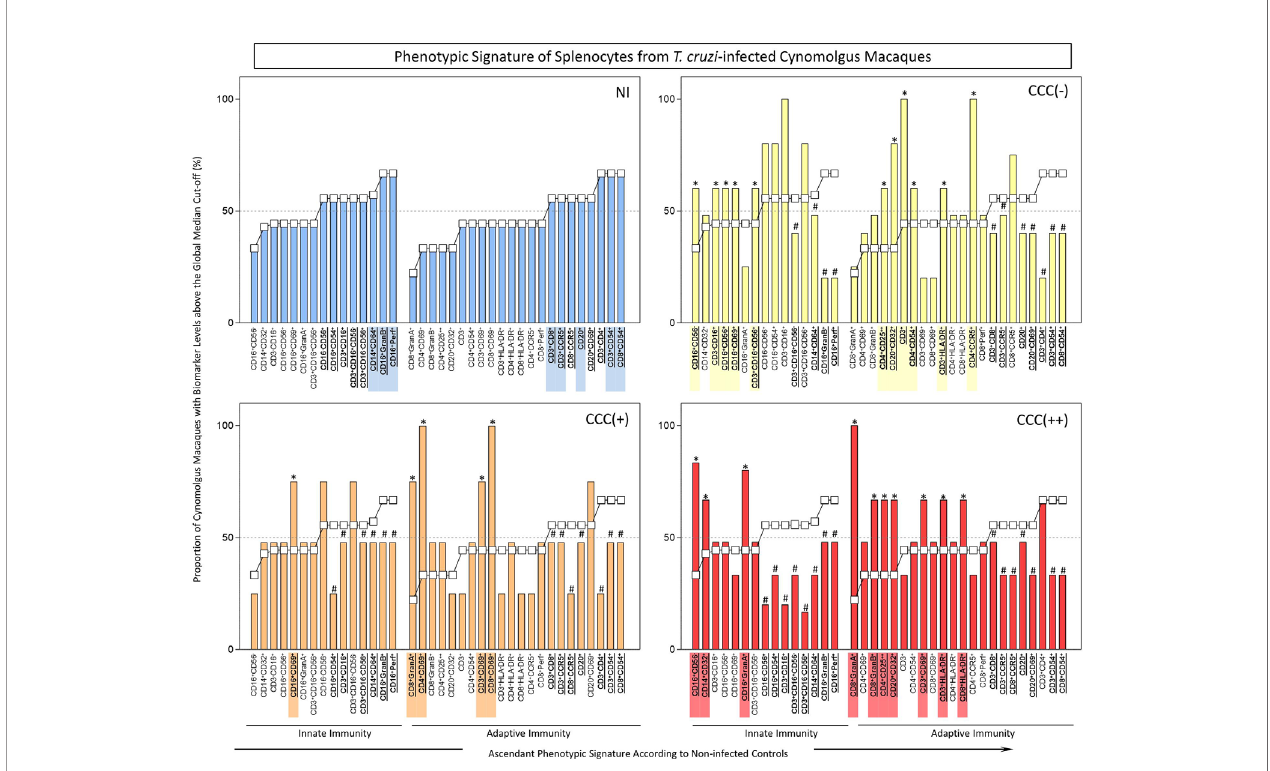
FIGURE 2 | Ex-vivo phenotypic signatures of splenocytes from T. cruzi -infected cynomolgus macaques classi fi ed according to histopathological features of chronic chagasic cardiopathy. See legend to Figure 1 for